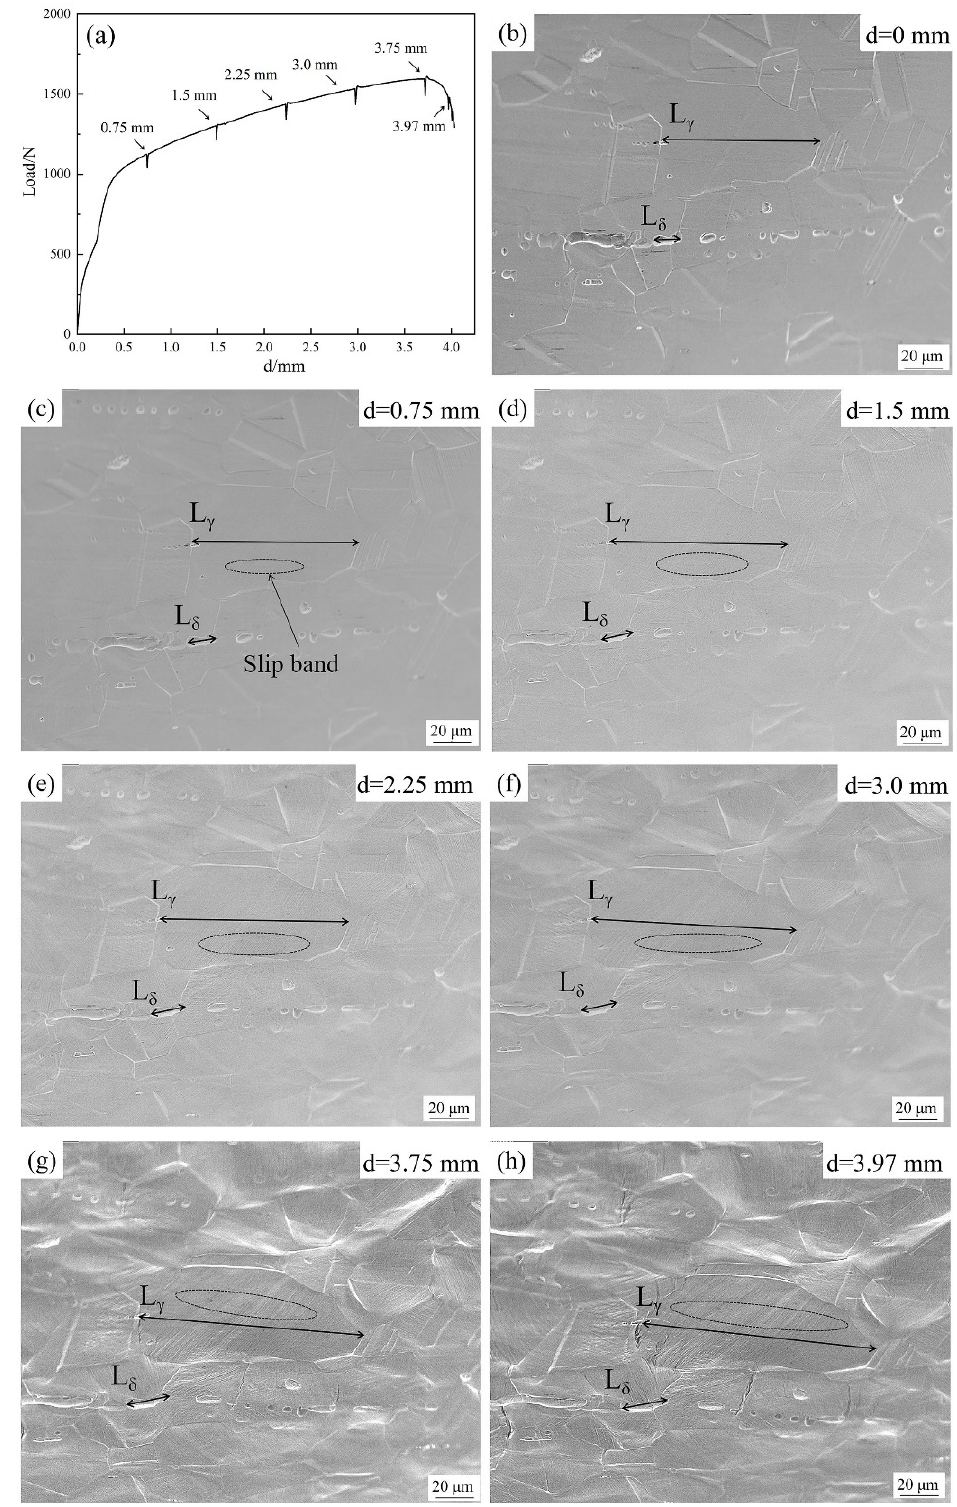
Figure 11. ( a ) Load-displacement relationship curve of steel 1# and ( b–h ) SEM analysis of micro- structure under different displacements. 𝐿 (cid:3082) and 𝐿 (cid:3083) are the size of austenite and δ -ferrite, respec- tively.